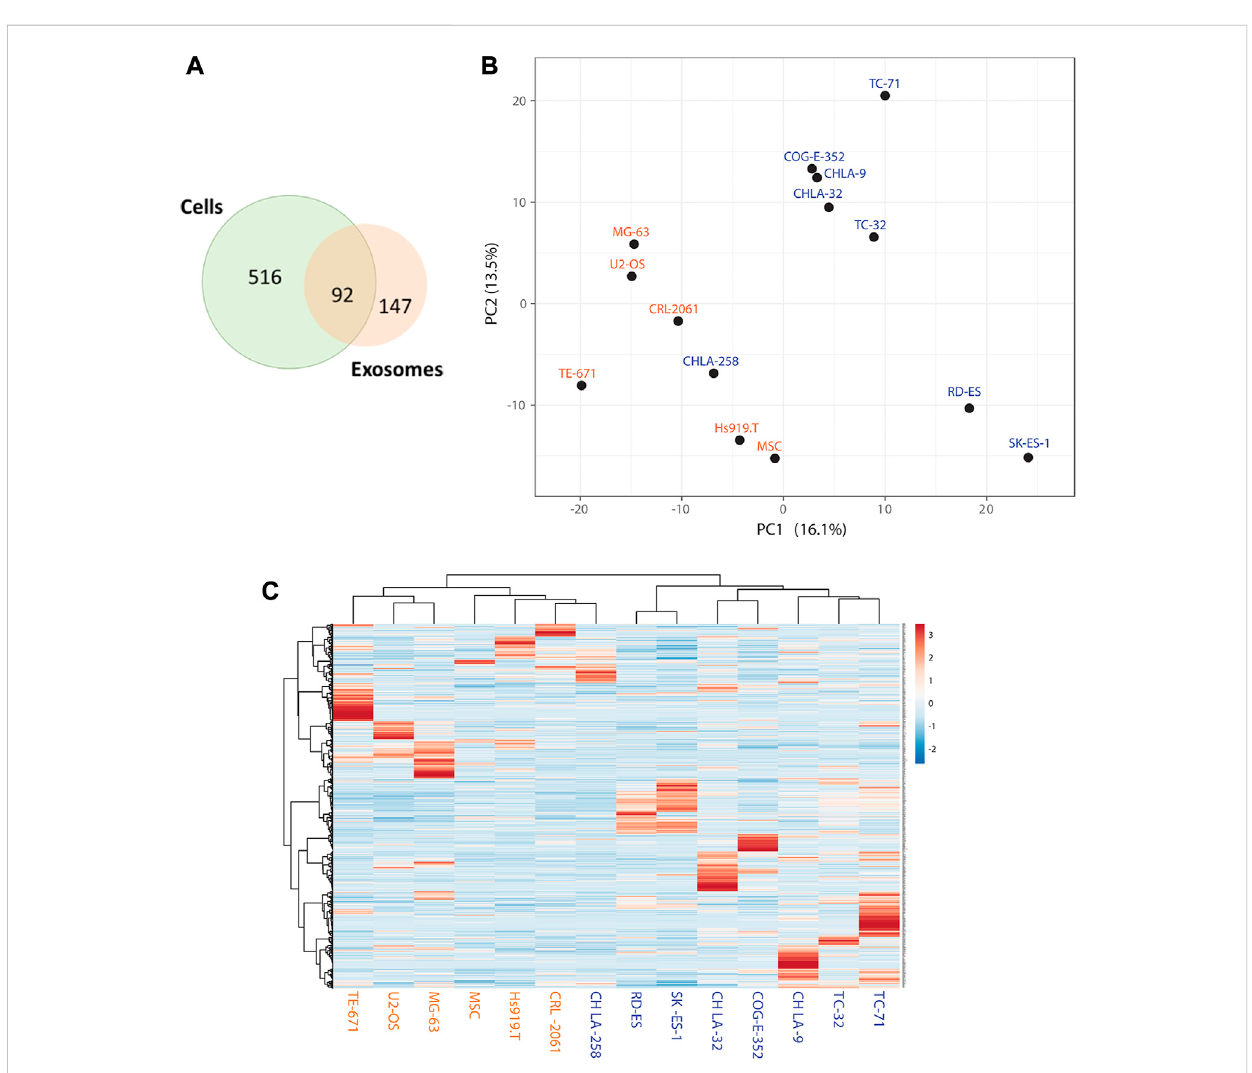
FIGURE 1 Identi fi cationofEnrichedsEVProteinsforEWSbyMass-spectrometry (A) Venndiagramrepresentingtotalnumberofproteinsidenti fi edinEWScells and sEVs and overlap of shared proteins between these two groups. (B) Principal Component Analysis (PCA) plot illustrating relatedness among the samples based on 1,294 protein expressions. The fi rst two principal components are shown, illustrating the degree of similarity between the samples. X and Y -axis show principal component 1 and principal component 2 with 16.1% and 13.5% of the total variance, respectively. (C) Hierarchical clusteringonall14samplesand1,294proteins.Rowsarecentered;unitvariancescalingisappliedtorows.BothrowsandcolumnsareclusteredPearson correlation as a distance and average as a method. Blue and orange color labels indicate EWS and non-EWS cells